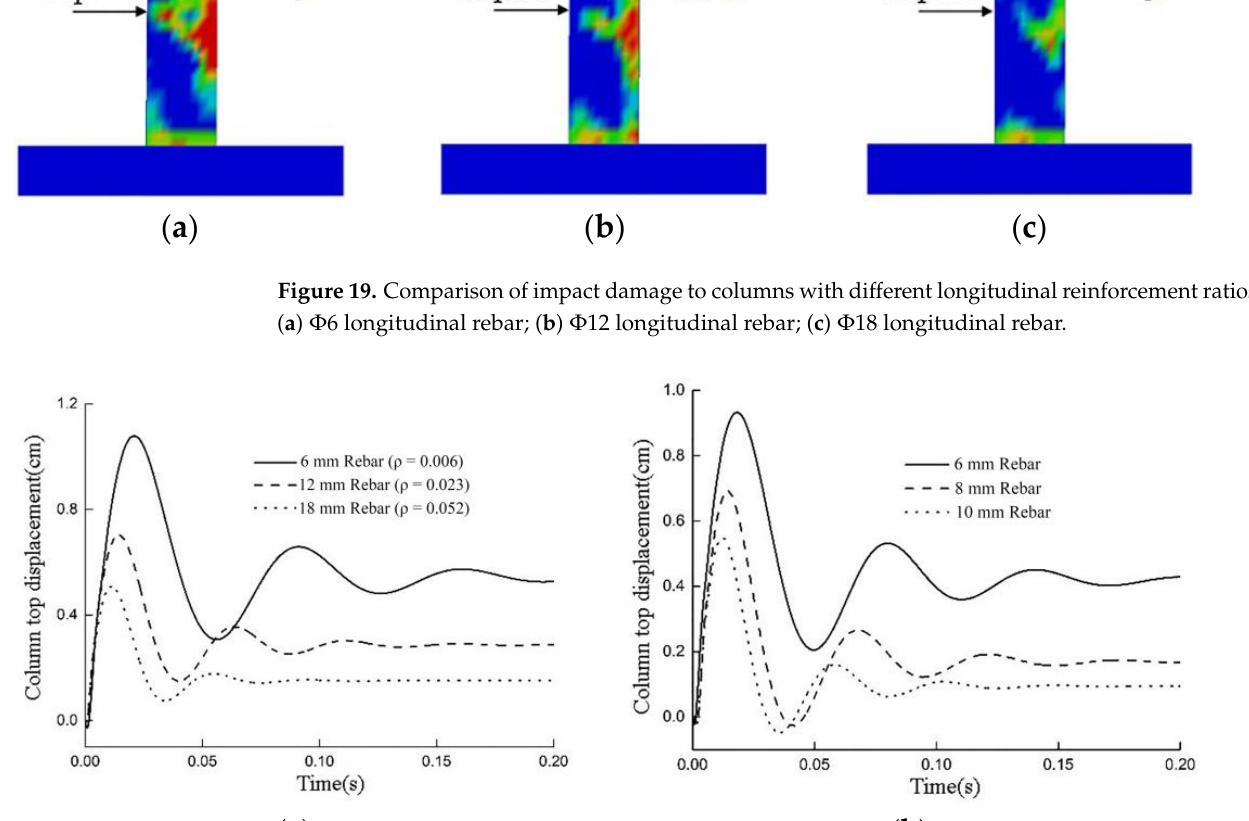
Buildings 2023 , 13 , x FOR PEER REVIEW 13 of 19